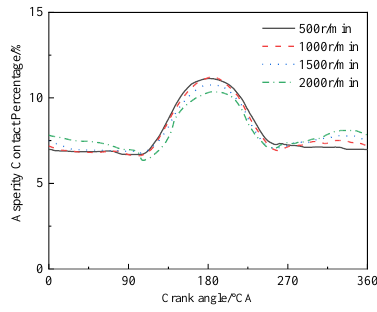
Figure 19. Asperity contact percentage.